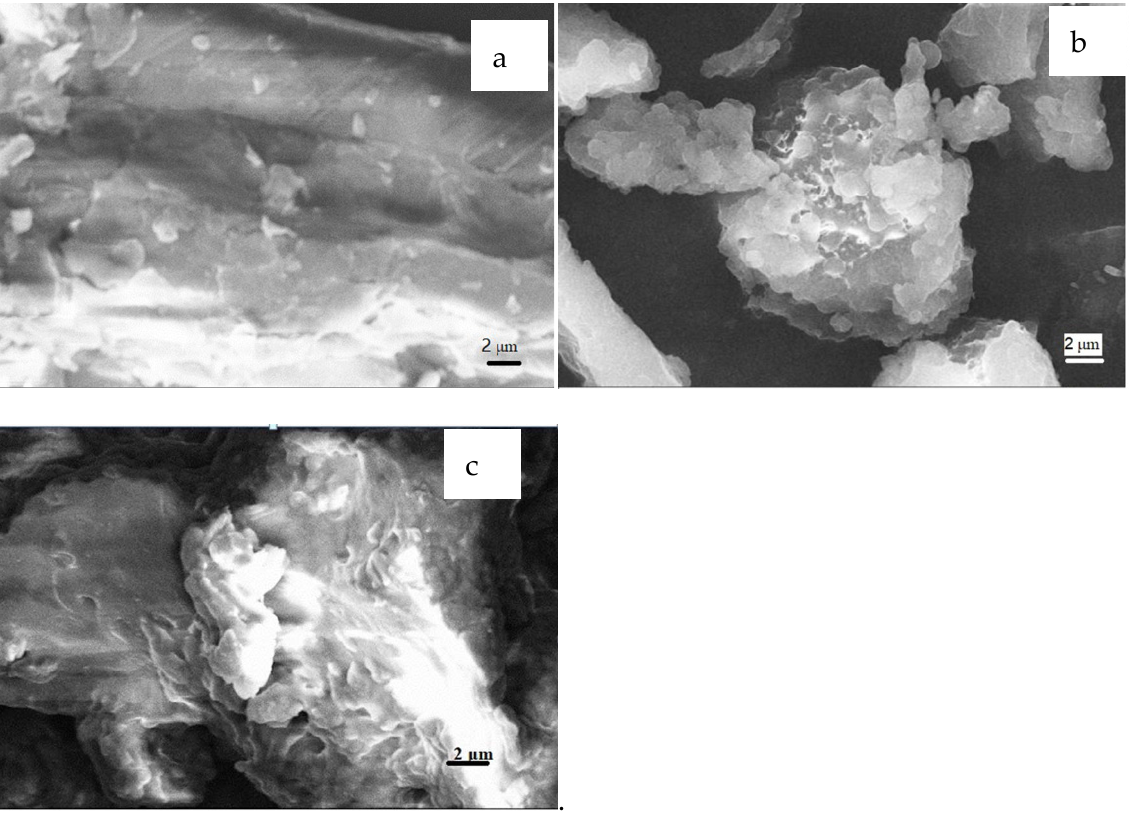
Figure 4. SEM images of original loofah ( a ), MML ( b ), and MML-Cu(II) ( c ).